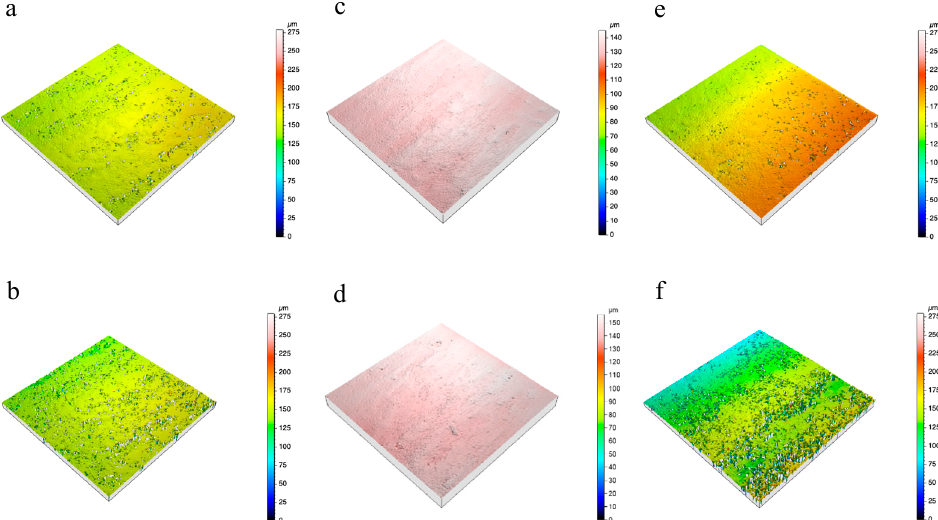
Figure 3. 3D topographical images obtained by confocal profilometry for ( a ) stem 1, before plasma treatment, ( b ) stem 1, after plasma treatment, ( c ) stem 2, before plasma treatment, ( d ) stem 2, after plasma treatment, ( e ) stem 3, before plasma treatment, and ( f ) stem 3, after plasma treatment